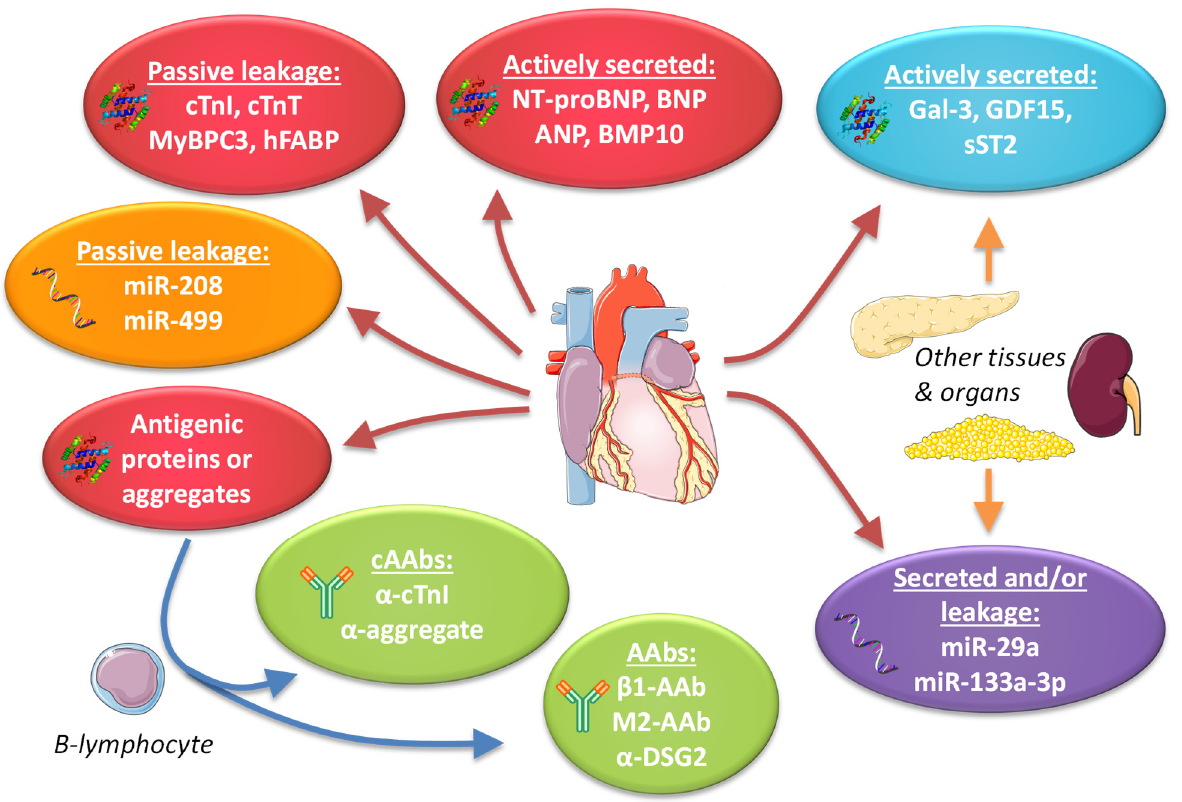
Figure 4. Overview of the current spectrum of potential biomarkers in genetic cardiomyopathies, including examples of biomarker proteins, noncoding RNAs (ncRNAs) and antibodies. Red/orange ovals indicate proteins/ncRNAs from the heart. Blue/purple: ovals indicate proteins/ncRNAs from multiple tissues. Green ovals indicate antibodies. AAbs = autoantibodies, cAAbs = cardiac autoantibodies, BNP = B-type natriuretic peptide, ANP = atrial natriuretic peptide, BMP10 = bone morphogenetic protein 10, Gal-3 = galectin-3, GDF15 = growth differentiation factor 15, sST2 = soluble suppression of tumorigenesis-2, β 1 = G-protein coupled β 1 receptor, M2 = muscarin-2 receptor, DSG2 = desmoglein-2, cTnI = cardiac troponin I, cTnT = cardiac troponin T, MyBPC3 = cardiac myosin-binding protein C3, hFABP = heart-type fatty acid-binding protein. Components of the figure are derived from Servier Medical Art (https://smart.servier.com/, accessed on 14 March 2021), licensed under a Creative Commons Attribution 3.0 Unported License (https://creativecommons.org/licenses/by/3.0/, accessed on 14 March